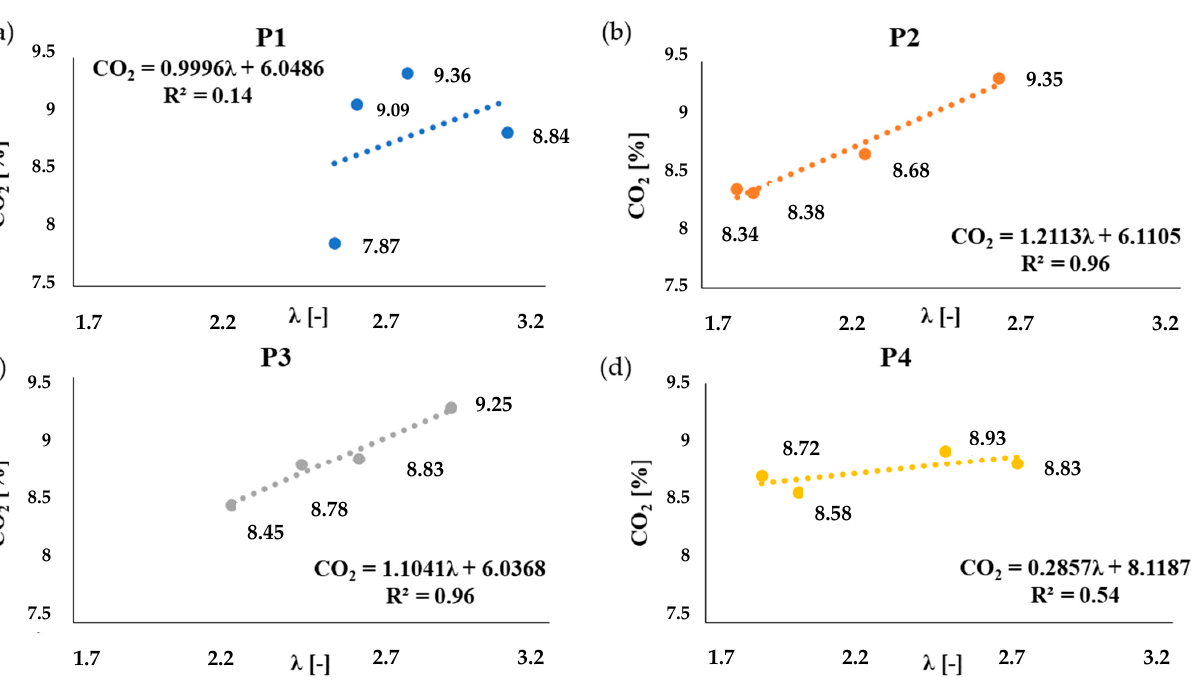
Figure 6. Emission of CO 2 during pellet combustion in dependence on the air supplied to the combustion chamber ( a ) P1, ( b ) P2, ( c ) P3, ( d ) P4. Carbon monoxide, the product of incomplete combustion, is limited to an amount of 500 mg per 1 m 3 of exhaust at 10% oxygen content by the European Ecodesign Directive [21]. The content of CO during performed tests is shown in Figure 7 in dependence on the λ value. The CO content during the combustion of the tested pellets differs significantly at the lowest airflow values. Pellets P1 and P2 show (both A1) were found to exceed the sulted in a decrease in CO content (Figure 7) and an increase in CO 2 (Figure 6), which proves that the equilibrium of the oxidation reaction has shifted towards CO 2 . Venturini et al. [22] state that lower-quality pellets are more likely to cause high emis-